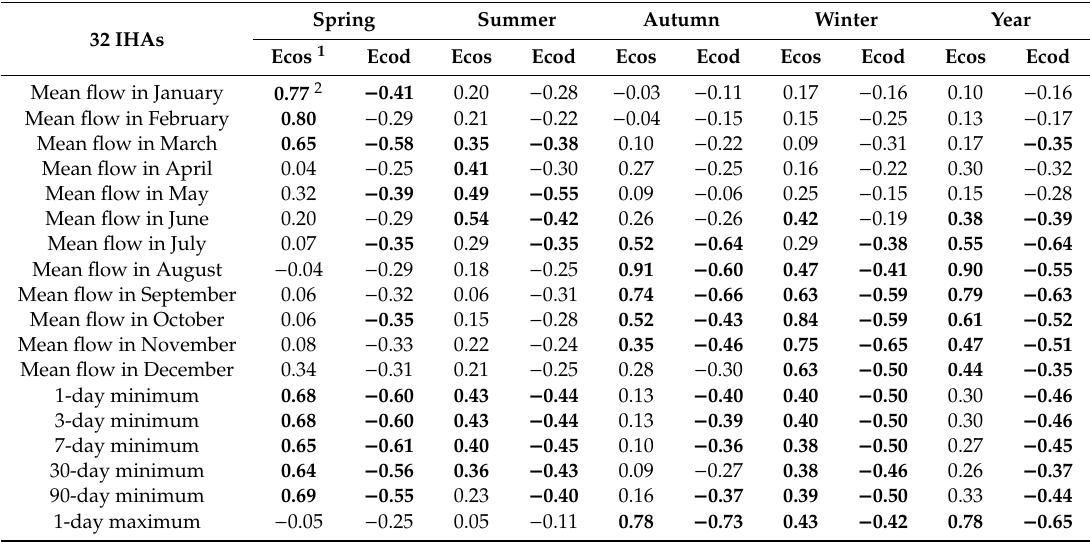
Table 6. Correlation coe ffi cient between the 32 IHAs and eco-flow